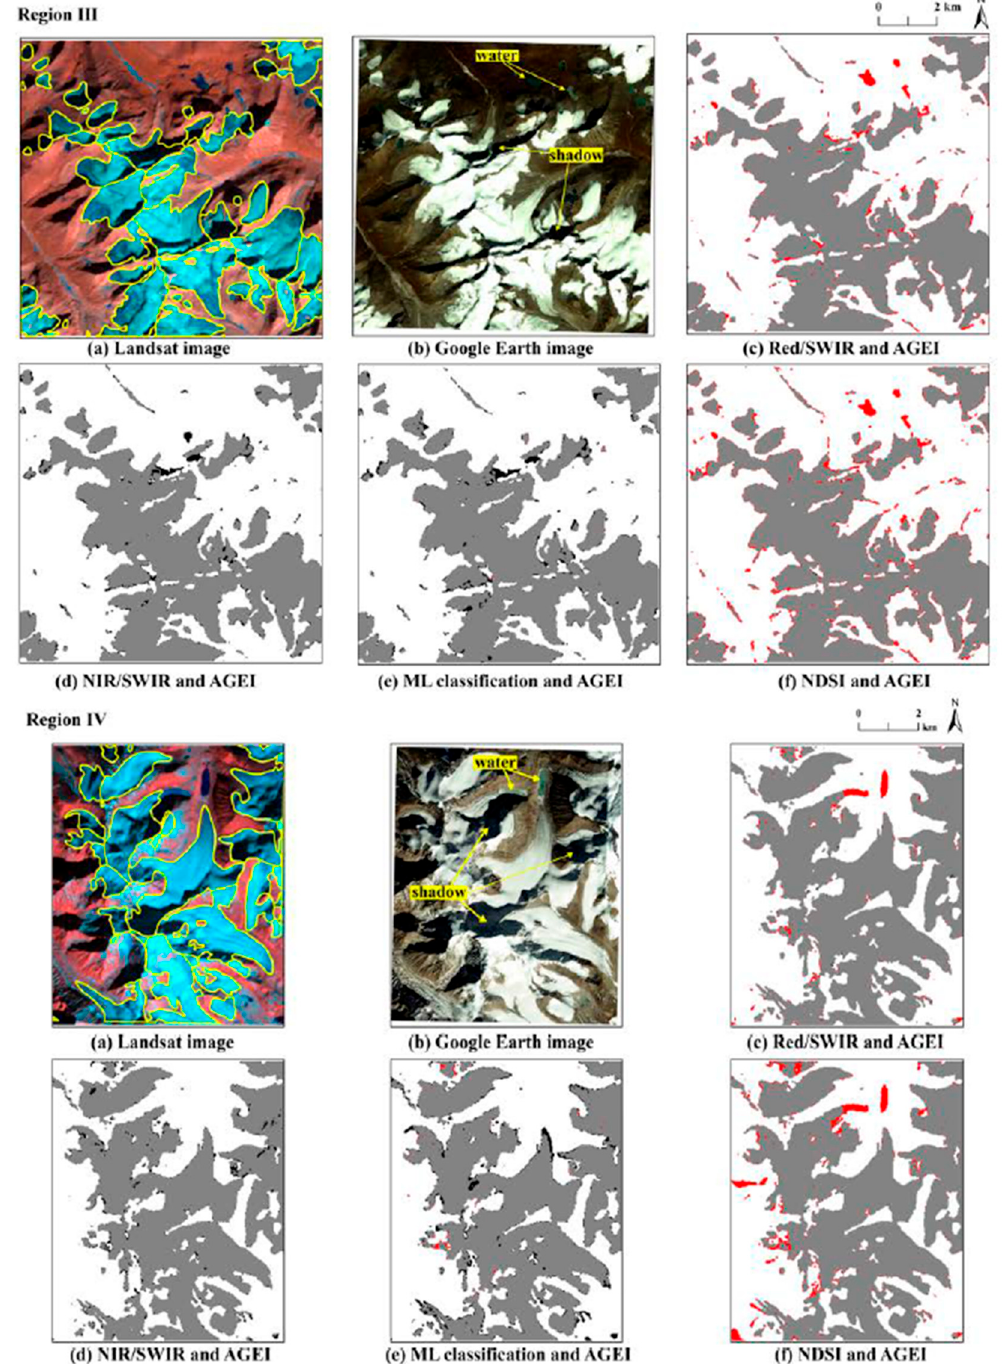
Figure 6. Glacier masks comparing two methods. Areas in grey were identified by both methods as being a glacier, red areas only by the first method, and black areas only by the second method in Region III and IV. ( a ) Superimposed map of manual glacier delineations and Landsat images of test sites; and ( b ) high resolution Google Earth images of test sites. The compared methods are: ( c ) Red / SWIR and AGEI; ( d ) NIR / SWIR and AGEI; ( e ) supervised ML classification and AGEI; ( f ) NDSI and AGEI.